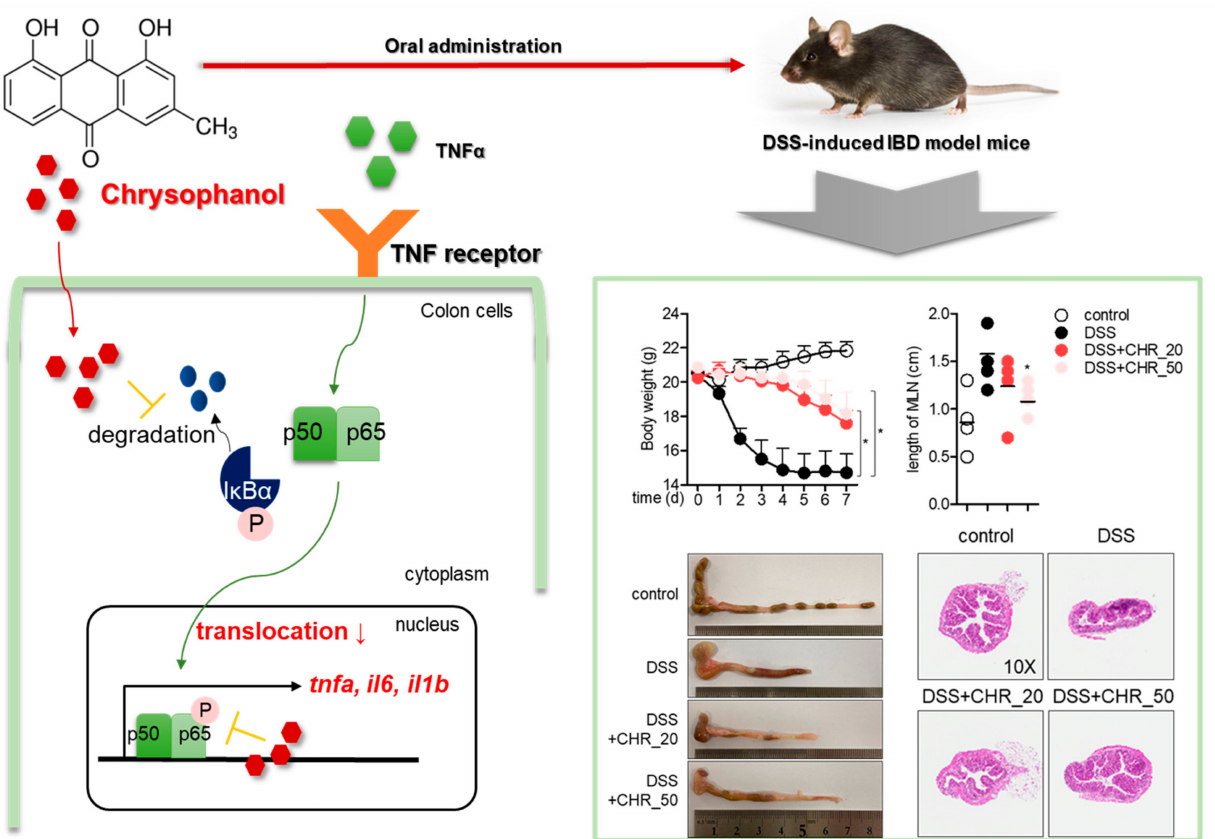
Figure 7. A schematic model for the protective effect of chrysophanol in the DSS-induced IBD model. * p < 0.05 compared with DSS-treated